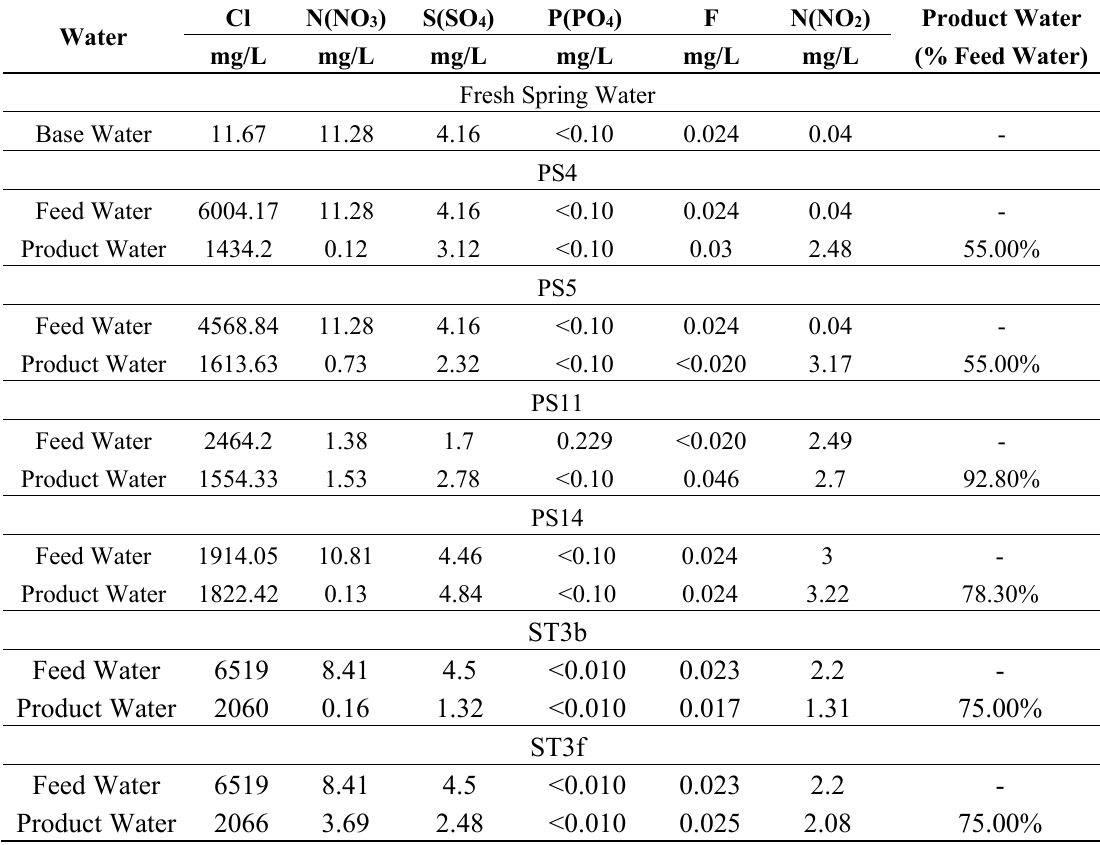
Table C1. Measured Anion Concentrations in the Feed and Product